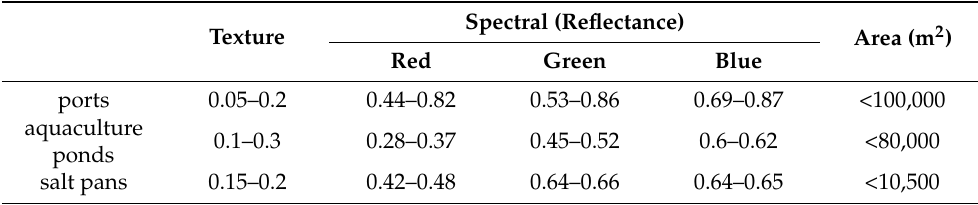
Table 5. Value ranges of spectral reflectance, texture, and area for different reclamation types for training data.